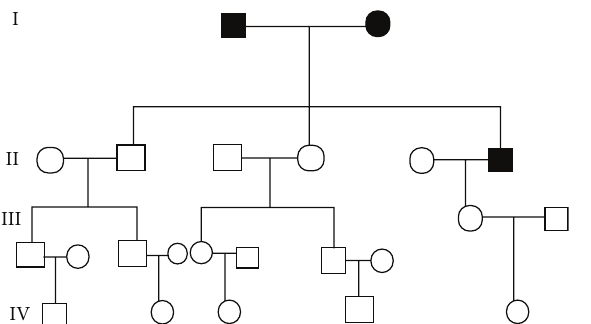
Figure 1: Specific cancer history was recorded on his pedigree; his father died of hepatic cancer and his mother died from lung carcinoma ( e ◼ represents one who had cancer).